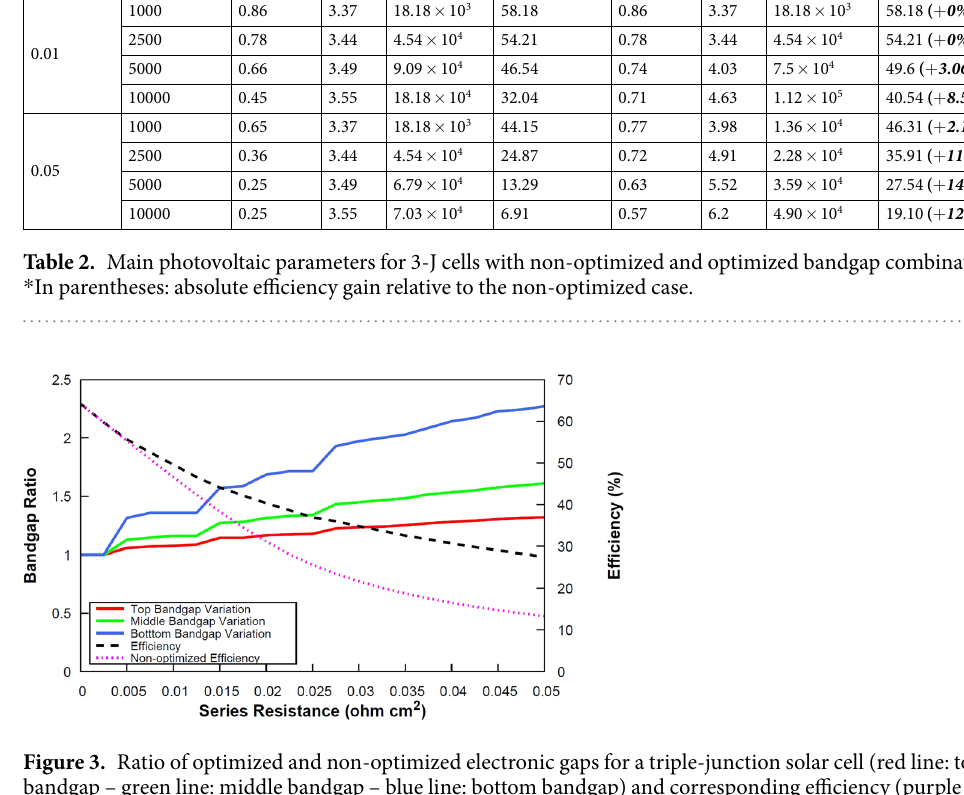
5 Scientific RepoRts | 7: 1766 | DOI:10.1038/s41598-017-01854-6